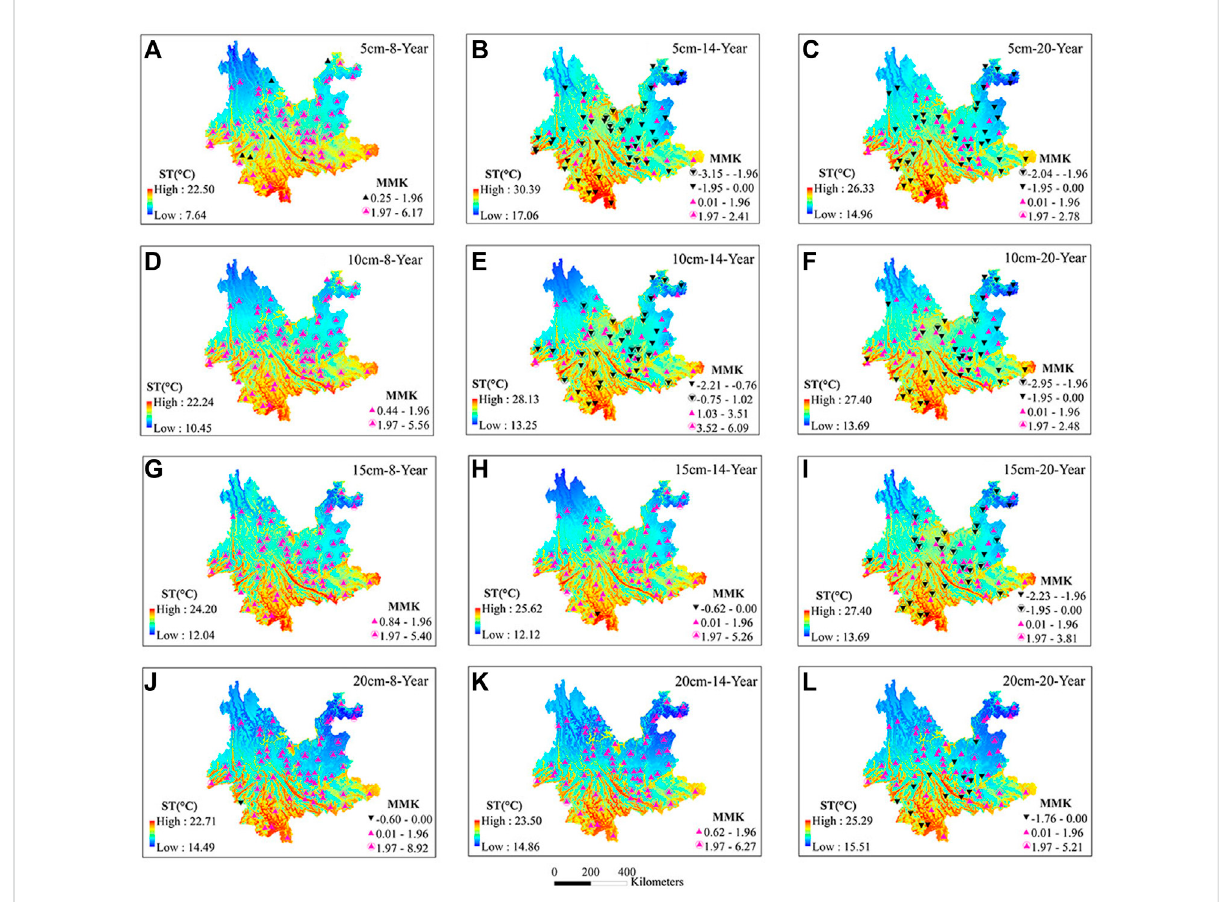
FIGURE 10 Spatial variation of annual hourly average temperature and slope at depths of 5 – 20 cm at 08:00, 14:00, and 20:00 in